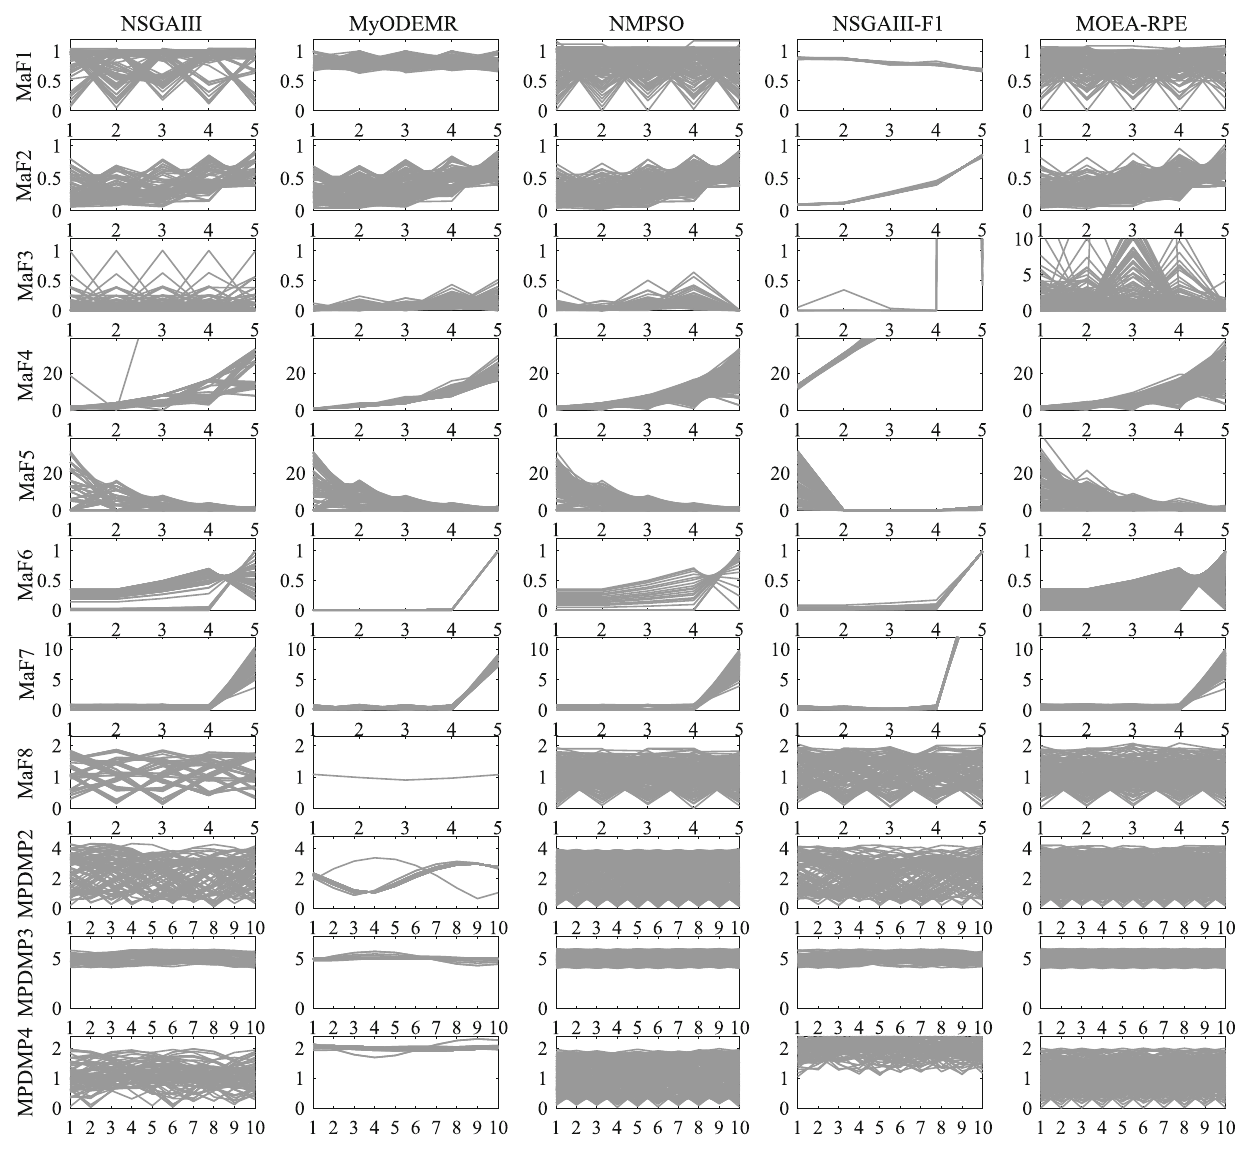
Fig. 6 Solutions with medium performance on MaFs and